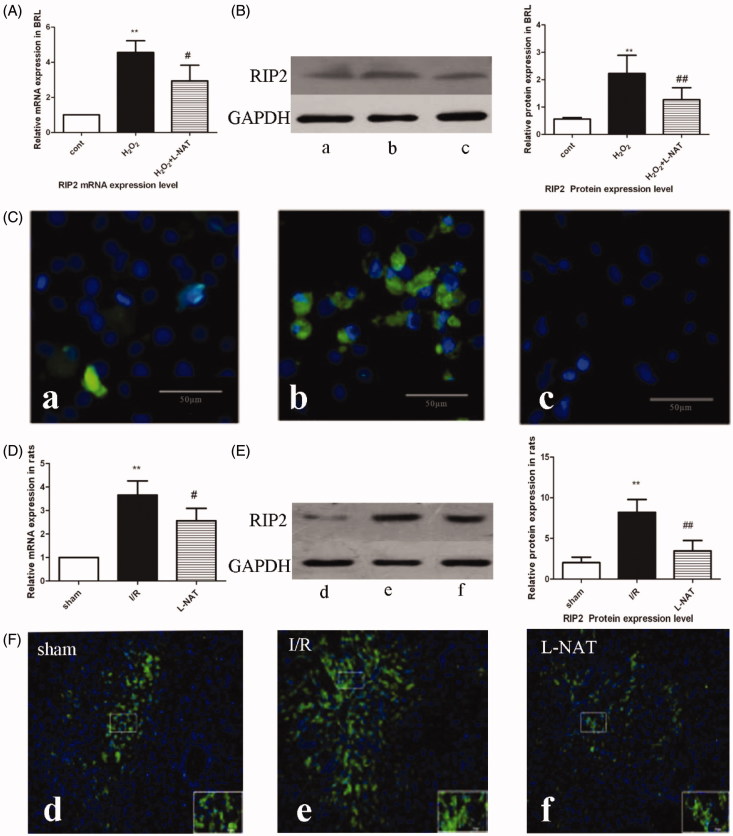
Changes in the expression of RIP2 after HIRI. (A) Relative mRNA levels of RIP2 in BRL cells. Detected by quantitative qRT-PCR (n = 3). (B) Western blot analysis of RIP2 protein expression in BRL cells. (C) Immunofluorescence staining (200X) in BRL cells. (a) Cont, (b) H2O2, (c) H2O2+
l-NAT. (D) Relative mRNA levels of RIP2 in rat liver tissues detected using quantitative qRT-PCR (n = 3). (E) Western blot analysis of RIIP2 protein expression in rat liver tissues. (F) Immunofluorescence staining (200×) in rat liver tissues (d) sham, (e) I/R, (f) l-NAT. Data are mean ± SD; **p < 0.01, *p < 0.05 compared with the related Cont group or sham group, ##
p < 0.01, #
p < 0.05 compared with related H2O2 group or I/R group.